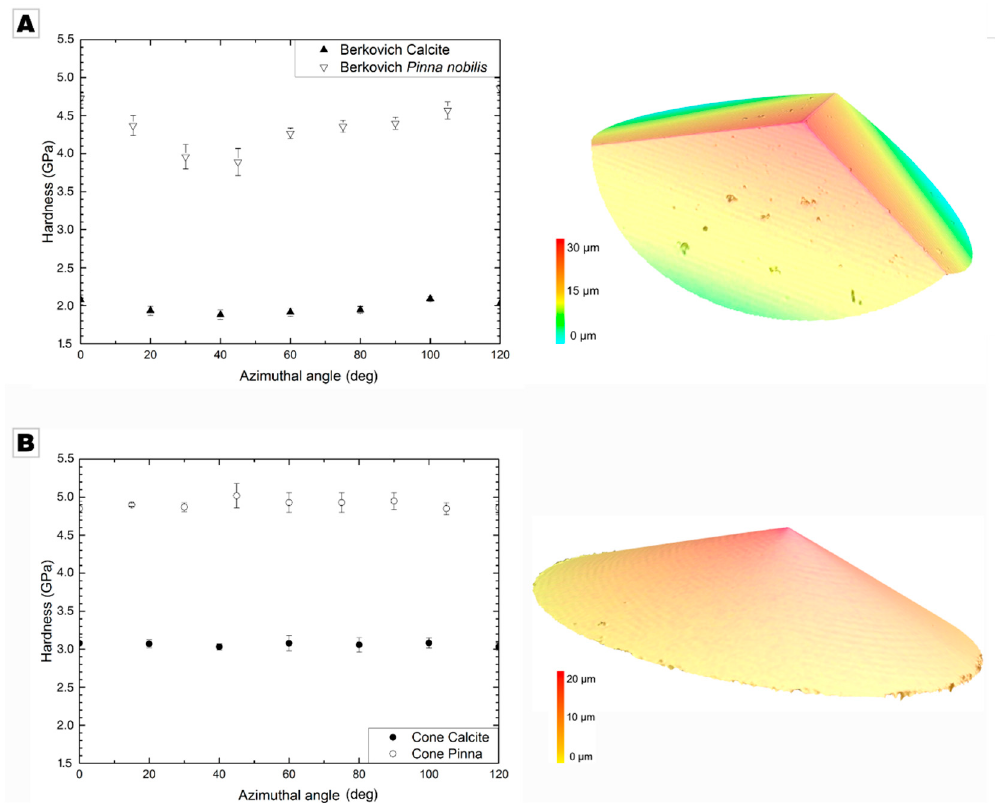
Figure 3. ( A ) Conventional Berkovich nanoindentation of biogenic calcite from Pinna nobilis and of geological calcite using a Berkovich indenter (depth: 100 to 250 nm); calcite shows a smaller azimuthal angle dependence compared to the biomineral Pinna nobilis . On the right, a 3D laser scanning micrograph of a Berkovich indenter is provided. ( B ) Azimuthal independent nanohardness indentation using a conical indenter in geological calcite and biogenic calcite (indentation depth: 100 to 250 nm). On the right, a 3D laser scanning micrograph of the conical indenter is